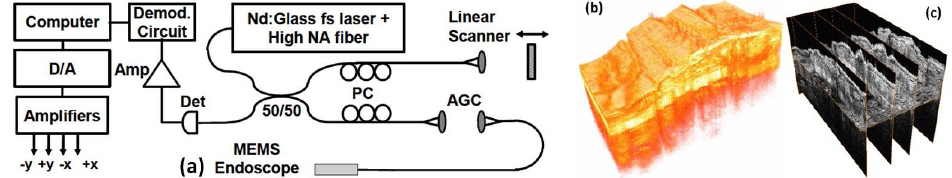
Figure 2. ( a ) OCT system schematic for imaging with the MEMS endoscope. PC: polarization control, AGC: air-gap coupling, Det: detector, Amp: amplifier, D/A: digital to analog Converter; OCT images acquired with the MEMS scanning catheter. ( b ) Three-dimensional rendering of the OCT volume dataset from a hamster cheek pouch; and ( c ) the serial cross-sections and en-face plane extracted from a 3D OCT volume of a hamster cheek pouch acquired in vitro. Reproduced with permission from [28]; published by OSA, 2007.